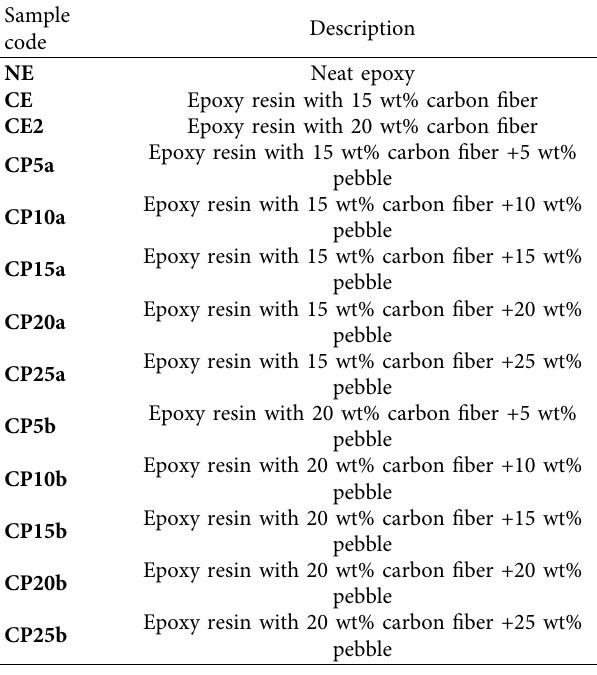
Table 1: Sample codes for all different types of epoxy composite